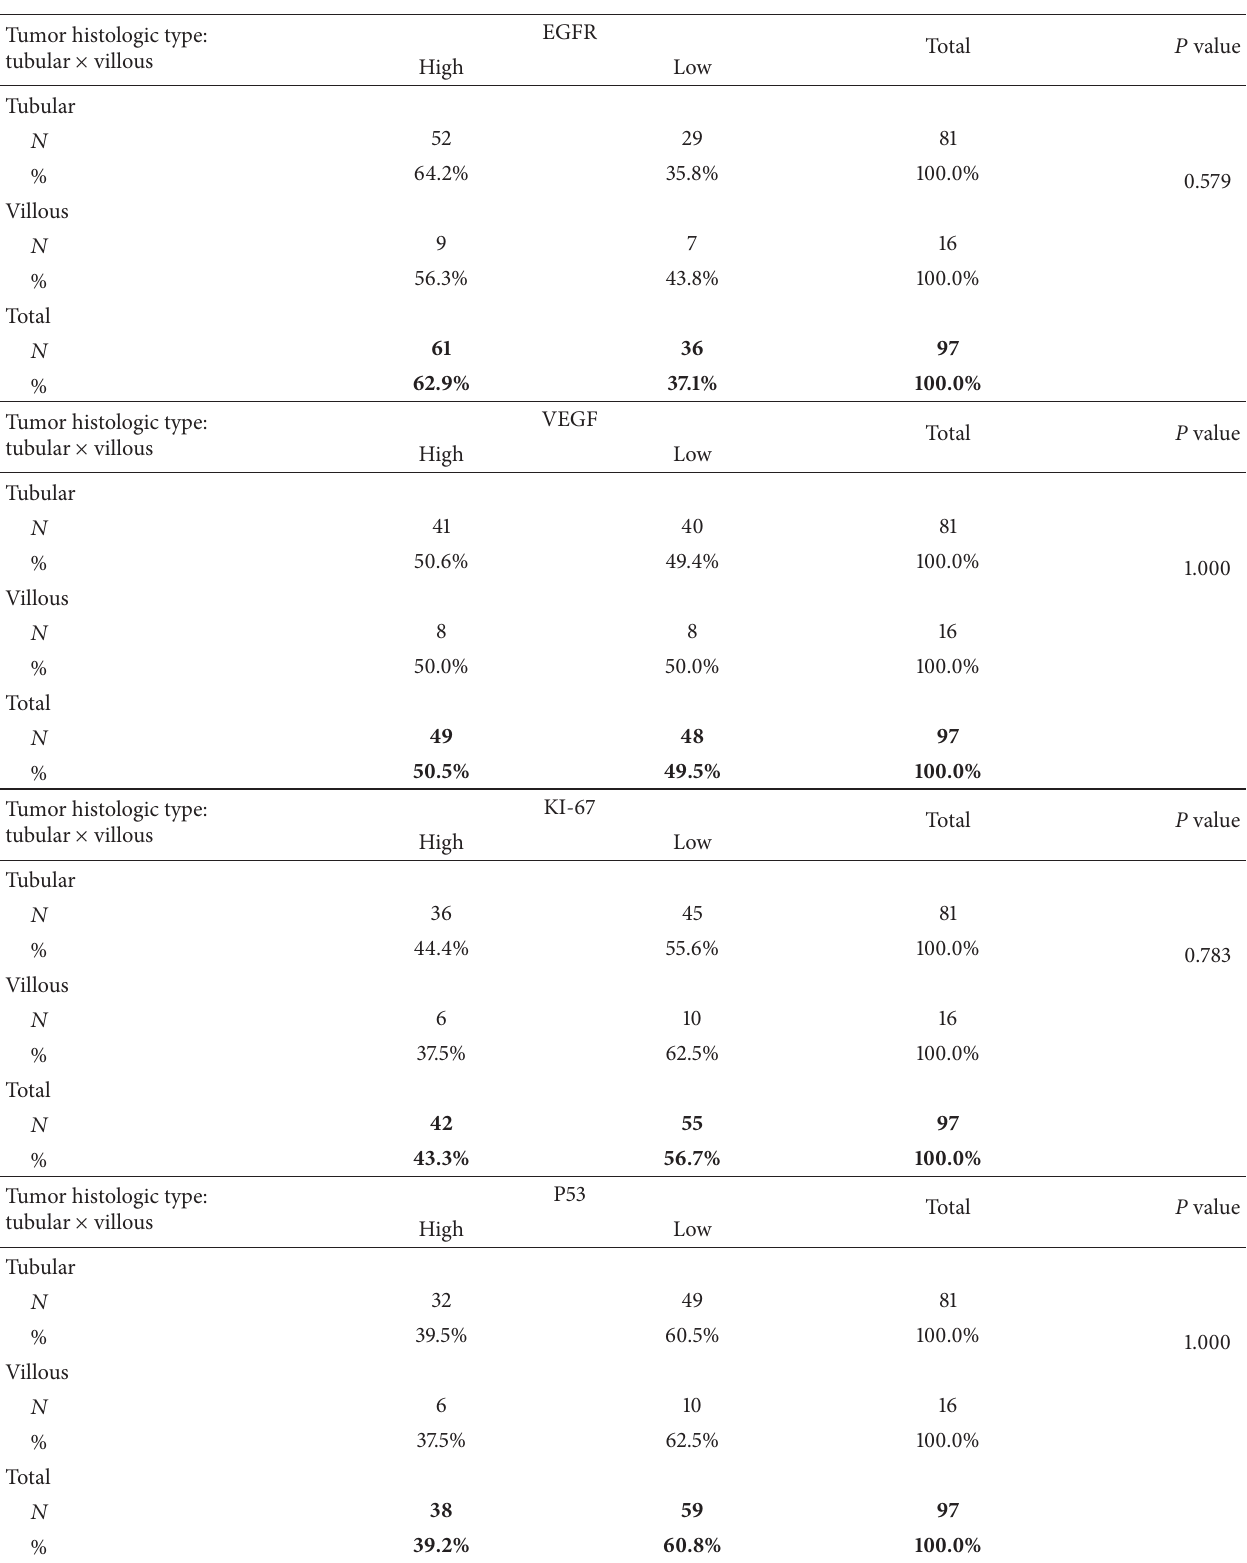
Table 8: The distribution of expression levels per IHC of proteins corresponding to ITGB-5, ITGA-3, MMP-2, MMP-9, and FN-1 ECM genes and EGFR, VEGF, KI-67, P53, and Bcl-2 molecules as per the villous and tubular types of CRC ( 𝑛 = 114